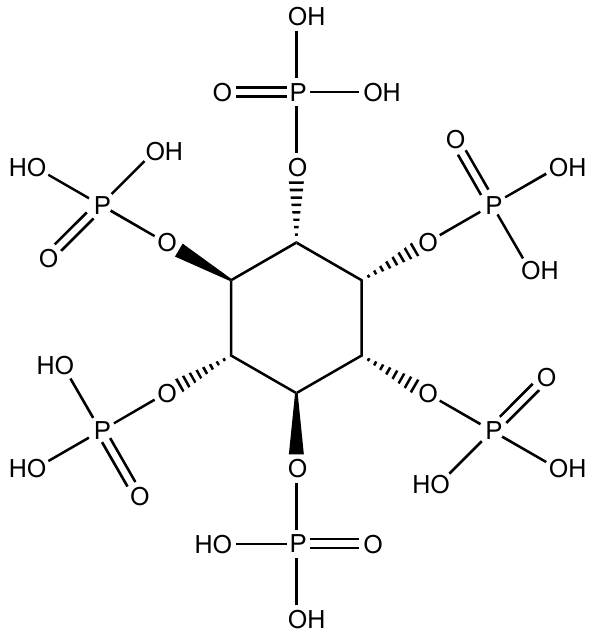
Figure 8. Structure of phytic acid.